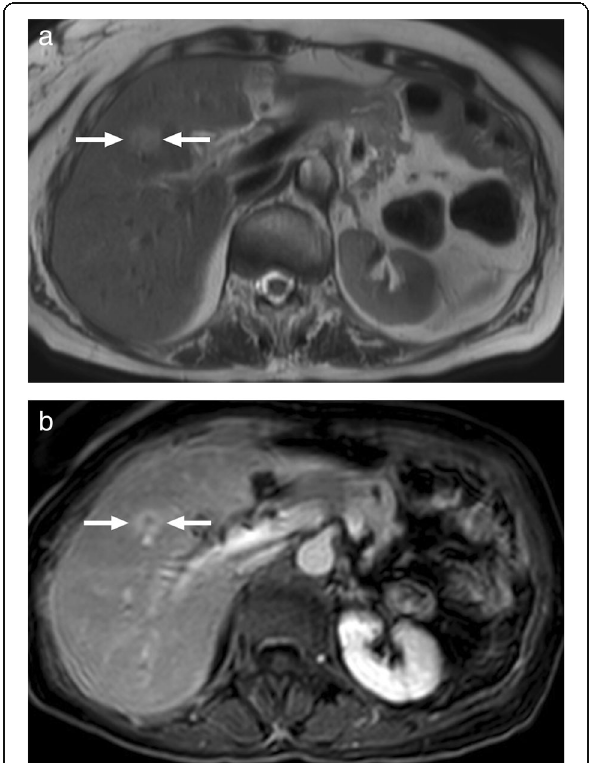
Fig. 8 A 64-year-old female with previously surgically treated pancreatic adenocarcinoma now presenting with a hypoechoic focal liver lesion detected in outside US. Clinically the patient was in complete remission for her tumor and her prior abdominal scan was normal. She was asymptomatic and had no fever. a Axial plane T2W MR image demonstrates a moderately hyperintense focal lesion (arrows) in the right liver lobe. b Axial plane postcontrast T1W MR image at the late arterial phase demonstrates marked ring enhancement in the periphery of the lesion (arrows) which was considered to be highly suspicious for an adenocarcinoma metastasis. Percutaneous biopsy did not demonstrate any neoplastic cells but was interpreted as an abscess. Follow up CT scan (not shown) after intense IV antibiotic treatment showed